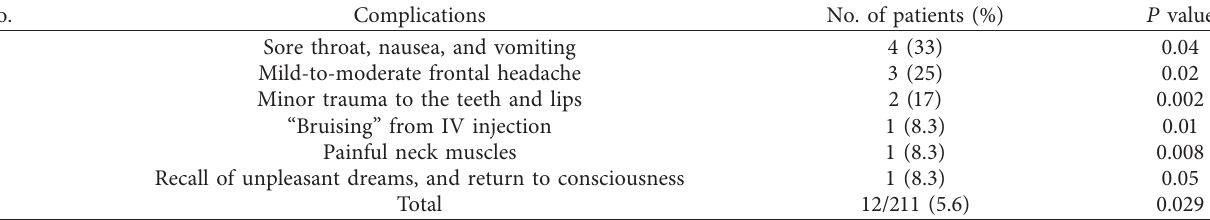
Table 4: List of complications related to general anesthesia.